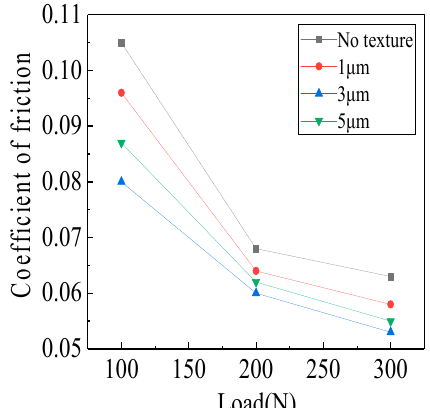
Figure 6. The coe ffi cients of friction corresponding to each pit depth under di ff erent load Figure 6. The coefficients of friction corresponding to each pit depth under different load conditions.